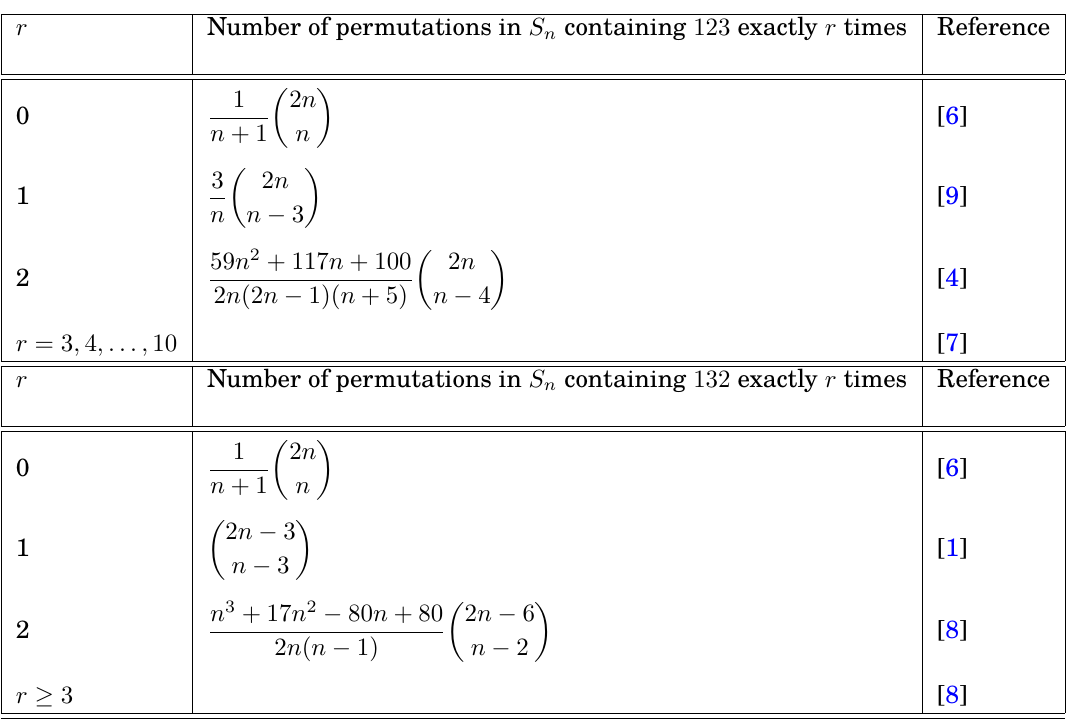
Table 1: Counting occurrences of 123 ( 132 ) in a